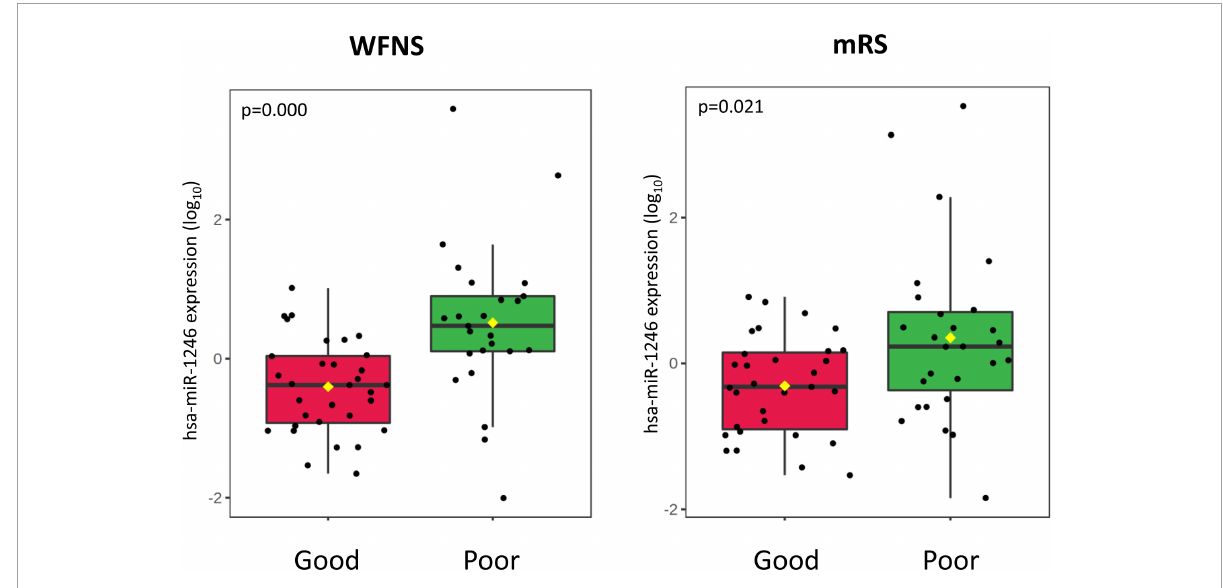
FIGURE6 Boxplot of the hsa-miR-1264 miRNA expression according to WFNS at hospital admission (left panel) and clinical outcome at 3 months (right panel) after